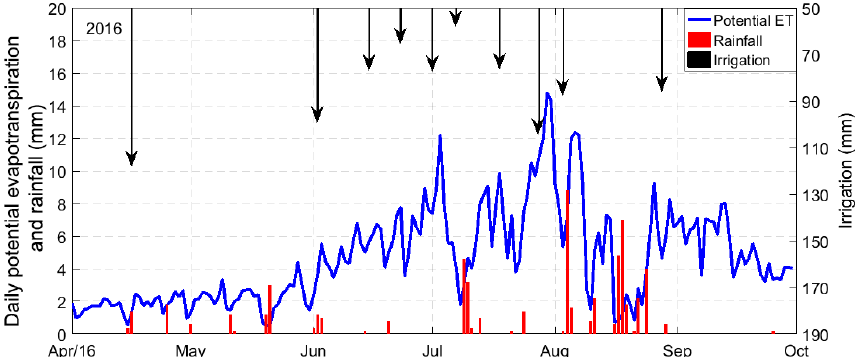
Figure 3. Measured daily rainfall and potential ET estimated using the Penman–Monteith method during the growing season of 2016 at the Linze Inland River Basin Research Station. The cumulative rainfall during the growing season was 69.2mm in 2016, and the black downward arrows represent irrigation events and average depths of water applied to the six plots during the